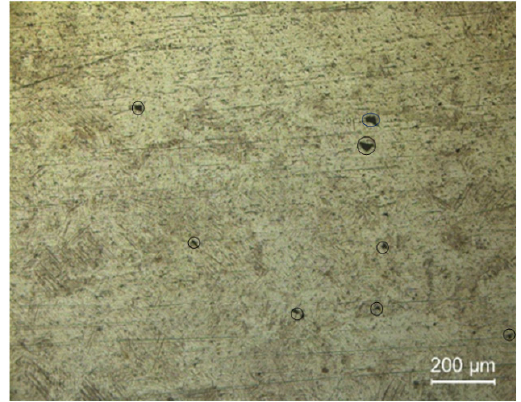
Figure 4. Microstructure of the D structure deposited by SLM.